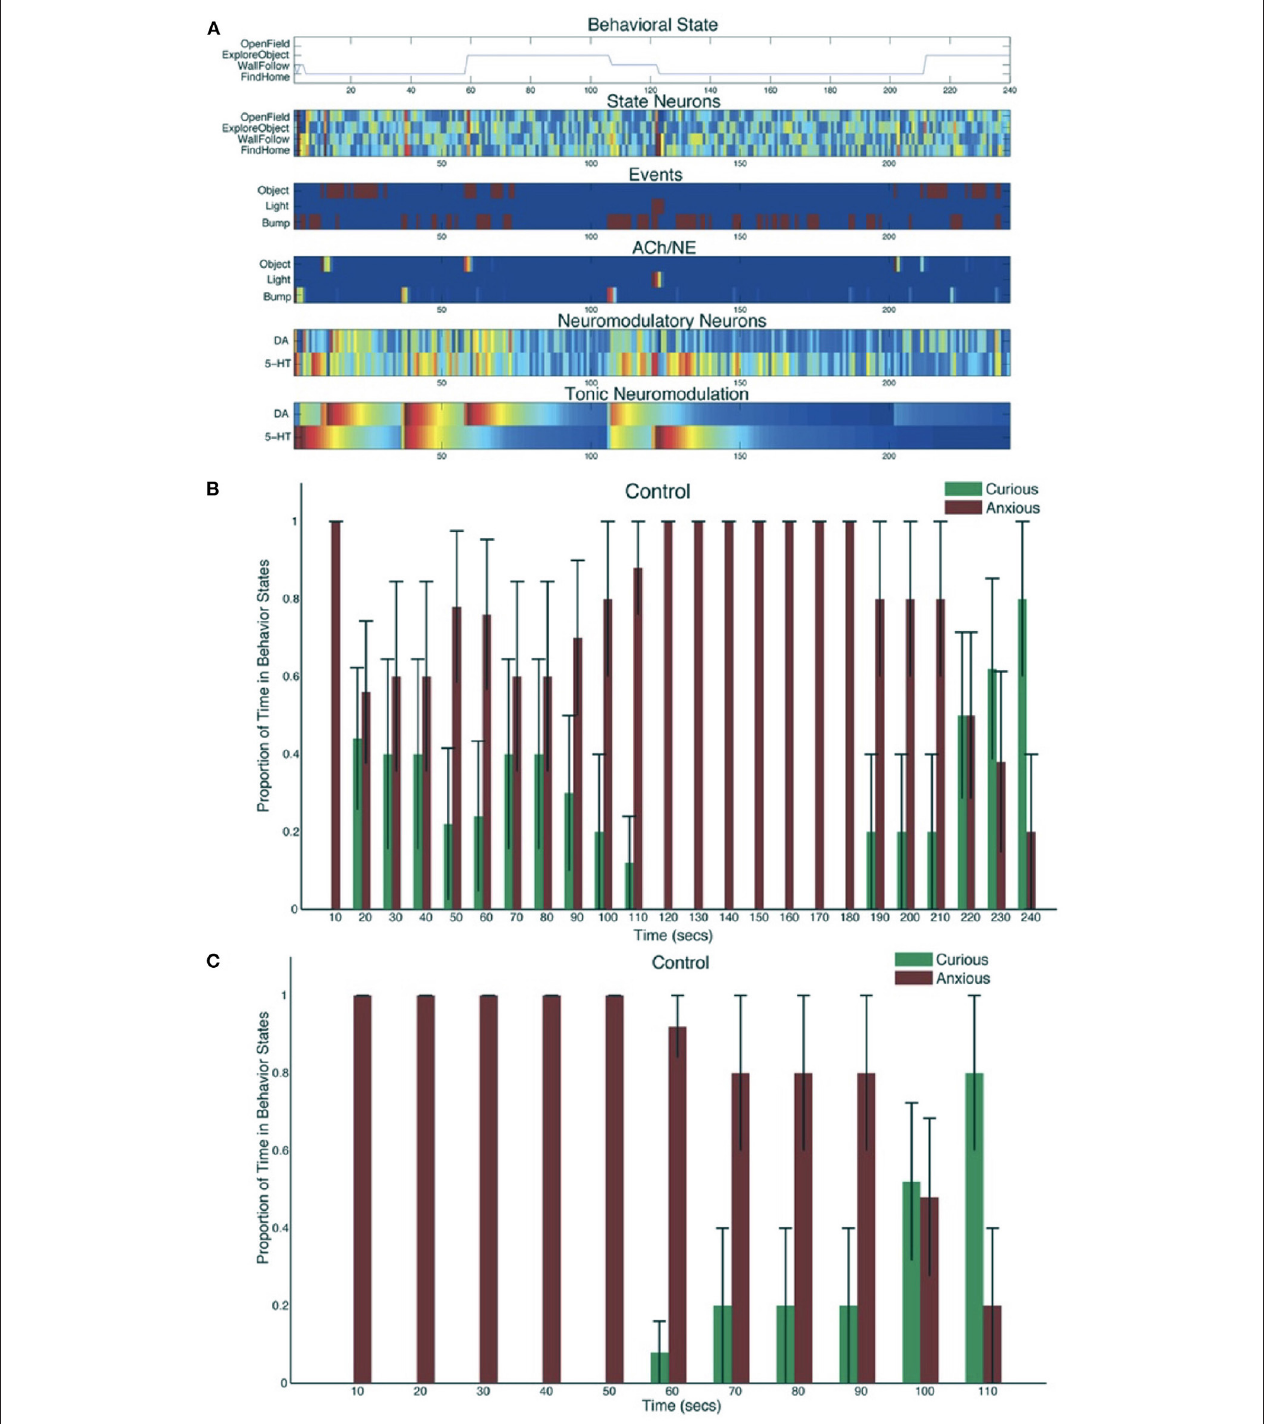
FIGURE 9 | Neurorobot results for invigorated and withdrawn behavior. (A) A representative example of behavioral and neural responses in a single trial. The x-axis shows time progression of the trial in seconds. The subplot for “Behavioral State” denotes the state of the robot across time. The subplots for “State Neurons,” “Events,” “ACh/NE,” and “Neuromodulatory Neurons” show neural activity over the trial with pseudocolors ranging from dark blue (no activity) to bright red (maximal activity). The subplot for “Tonic Neuromodulation” denotes the level of tonic activation contributing to DA and 5-HT neurons. (B) Proportion of time in Curious (ExploreObject and OpenField) and Anxious (FindHome and WallFollow) behavior, averaged over 5 trials. Error bars represent standard error. (C) Similar to B except the behaviors were time-locked to the Light event. Adapted from Krichmar (2013).